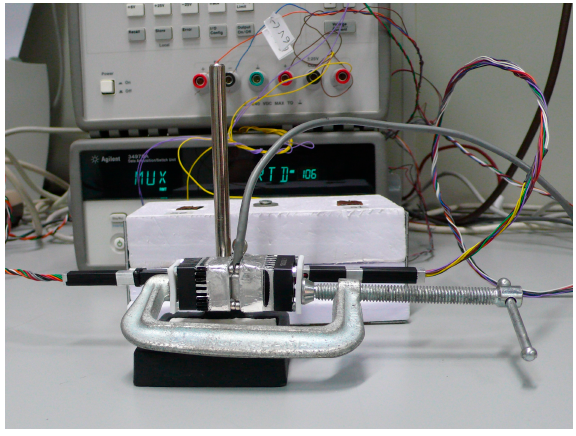
Figure 11. Placement of the two minisensors to determine their thermal resistances.